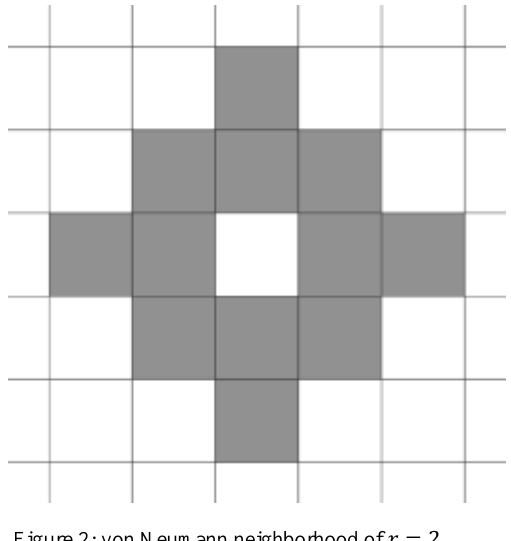
Figure 2: von Neumann neighborhood of 𝑟 = 2